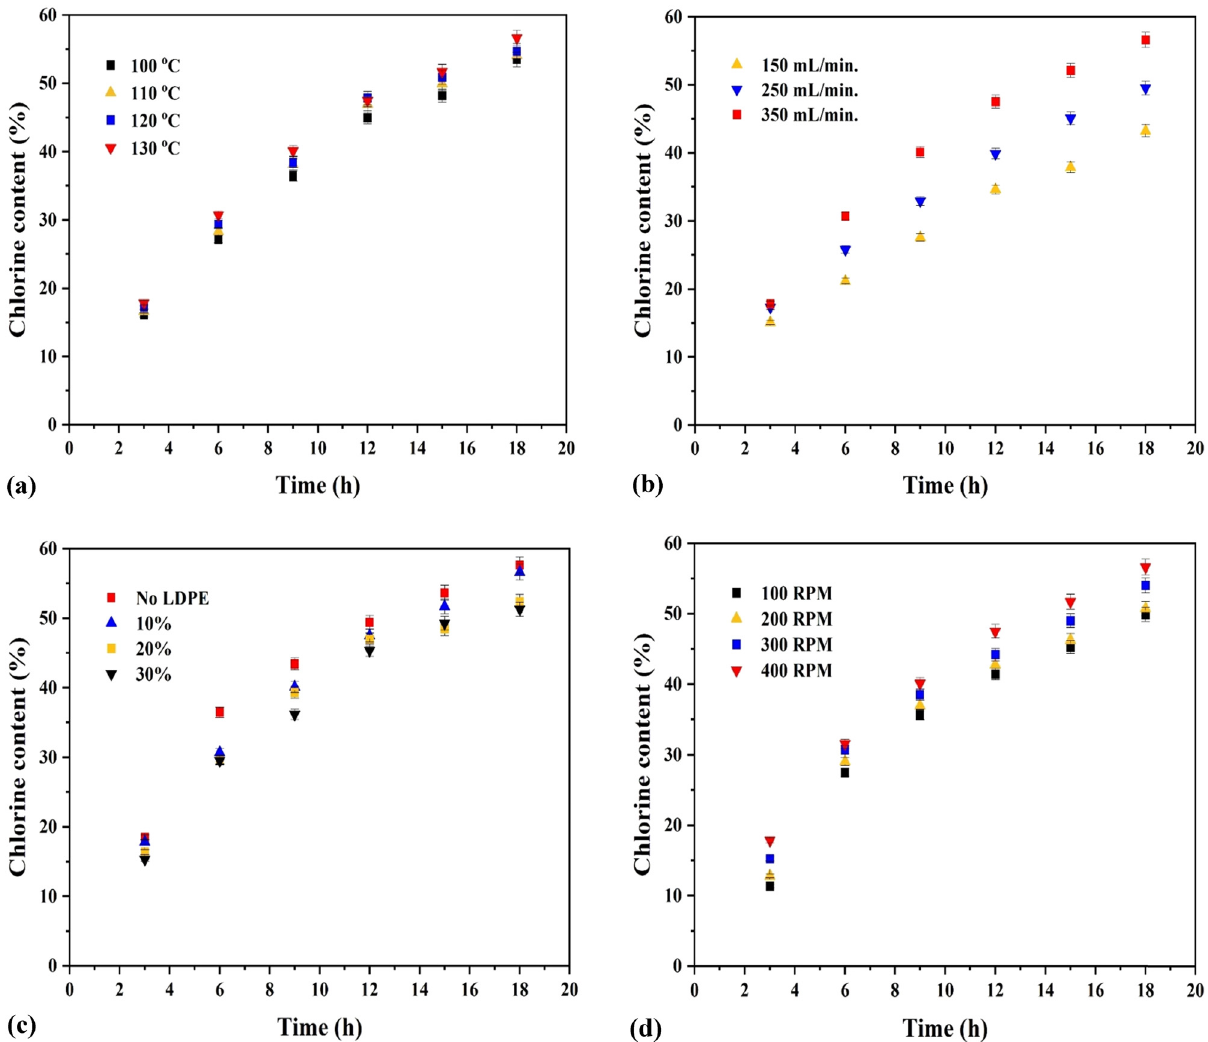
Figure 4: ( a ) E ff ect of temperature on co - chlorination ( chlorine fl ow rate 350 mL · min − 1 , 10% LDPE concentration, and 400 rpm ) ; ( b ) e ff ect of chlorine gas fl ow rate on co - chlorination ( 130°C, 10% LDPE concentration, and 400 rpm ) ; ( c ) e ff ect of concentration of LDPE on co - chlorination ( 130°C, chlorine fl ow rate 350 mL · min − 1 , and 400 rpm ) ; and ( d ) e ff ect of agitation on co - chlorination ( 130°C, chlorine fl ow rate 350 mL · min − 1 , and 10% LDPE concentration )